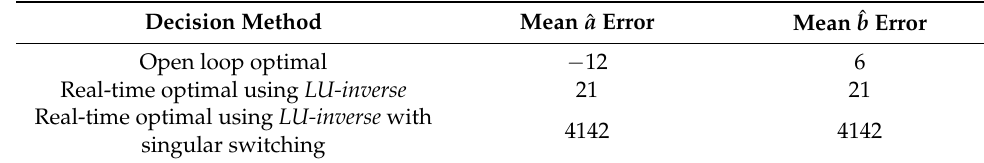
Table 8. Comparison of real-time optimal decision methods using LU-inverse matrix